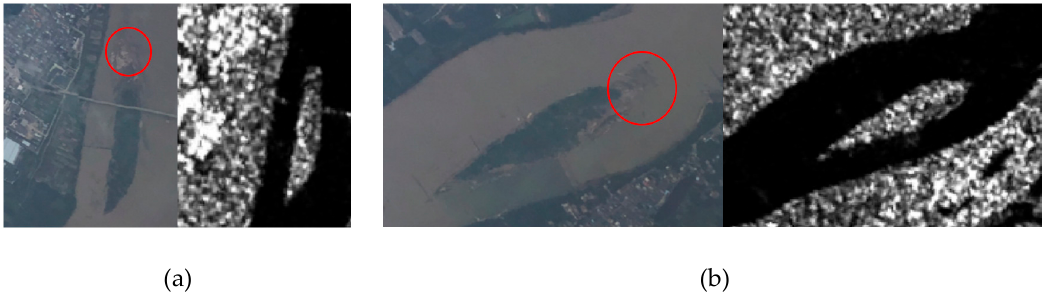
Figure 10. Typical discrepancies between flooded areas detected by ( a ) VPARS and ( b ) Sentinel-1 SAR images.